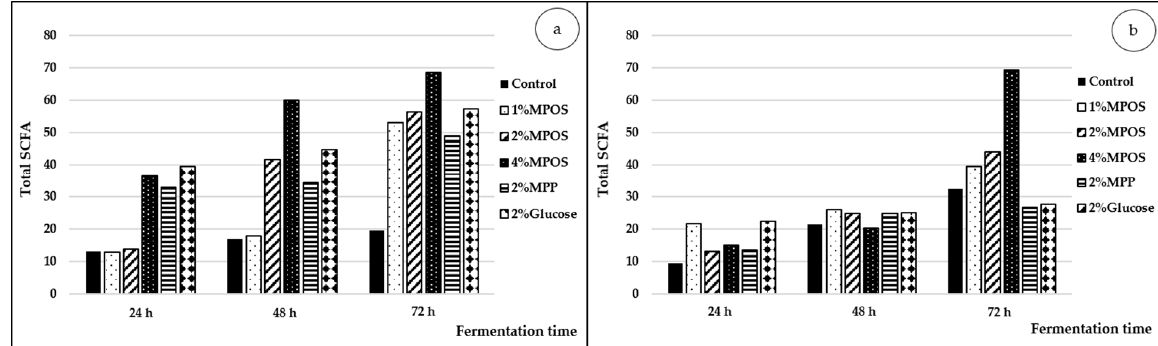
Figure 5. Total short chain fatty acid production of L. reuteri DSM 17938 ( a ) and B. animalis TISTR 2195 ( b ) cultivated in media supplemented with different carbon sources for 72 h of fermentation time.